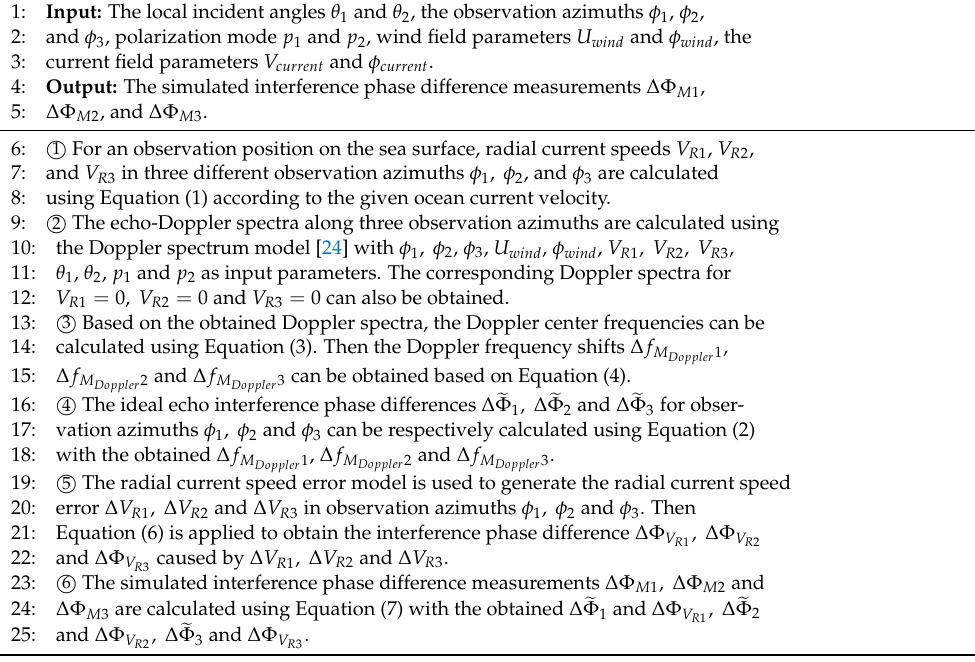
Algorithm 1 Data simulation for Doppler